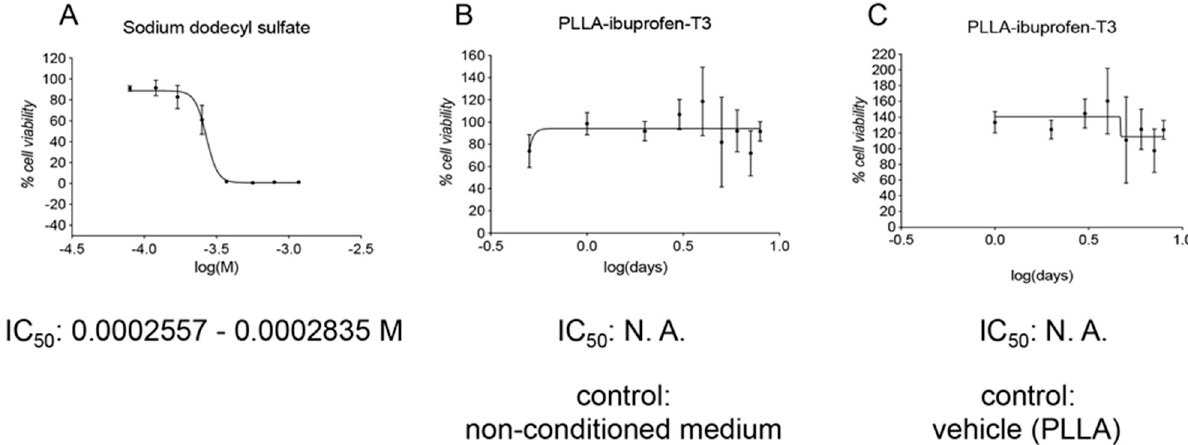
Figure 8. GLP toxicity in vitro evaluation of the delivery system. ( A ) The graph shows the cell viability normalized on the vehicle control group (100%) of cells exposed to different doses of sodium dodecyl sulfate. Concentrations on the x-axis are shown as the log of the Molarity; log(M). ( B , C ) The graphs show the cell viability normalized on the non-conditioned medium (100%; ( B )) or the PLLA (vehicle)-conditioned medium (100%; ( C )) of cells exposed to medium conditioned for different time lengths. Conditioning time on the x-axis is shown as the log of the conditioning days; log(days). For each graph, the IC 50 value is shown as the Molarity, or as N. A. (non-applicable) if it was not possible to calculate the value. Notably, this study proved that the presence of T3 does not alter the IC 50 of Ibu.